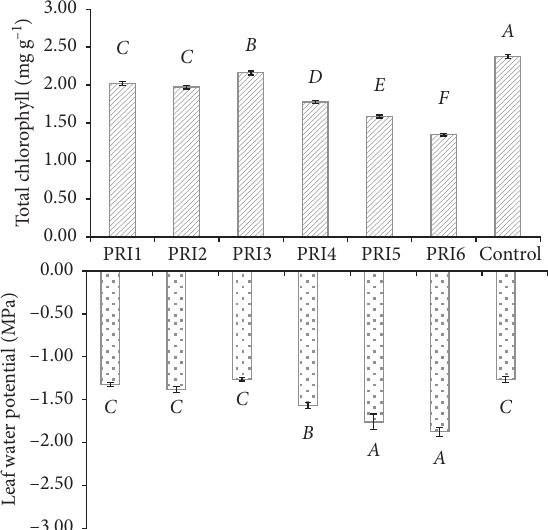
Figure 6: Leaf pigment concentration and water potential of PMK (R) 3 rice by split root experiment. Changes in total chlorophyll and leaf water potential at different partial root-zone irrigation treat- ments during 65 DAT. Error bars indicate one standard error of the mean. Different letters denote significant differences among means derived using an ANOVA and Student’s t